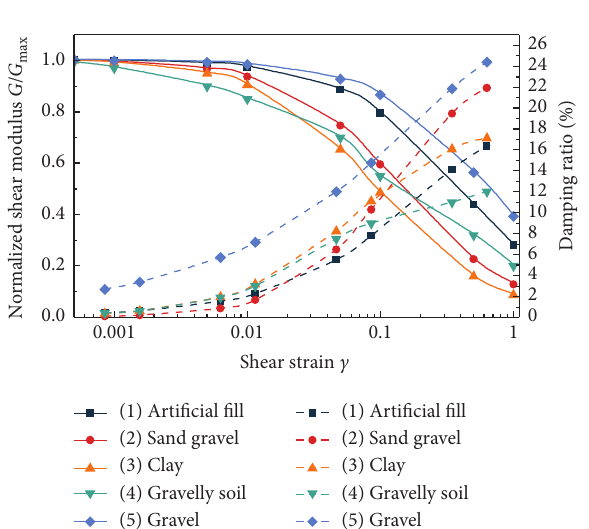
Figure 5: Variation of normalized shear modulus reduction (G/ Gmax) and material damping (%) with shear strain for ground layers.